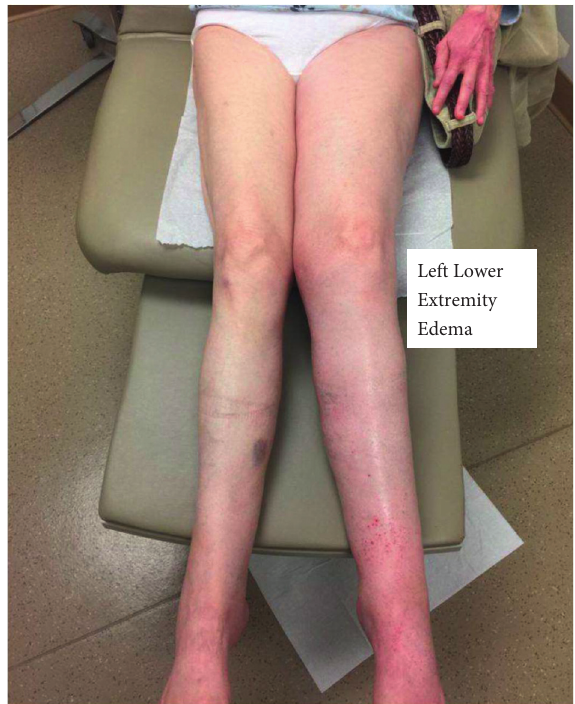
Figure 1: Patient’s initial presentation of left lower extremity edema.